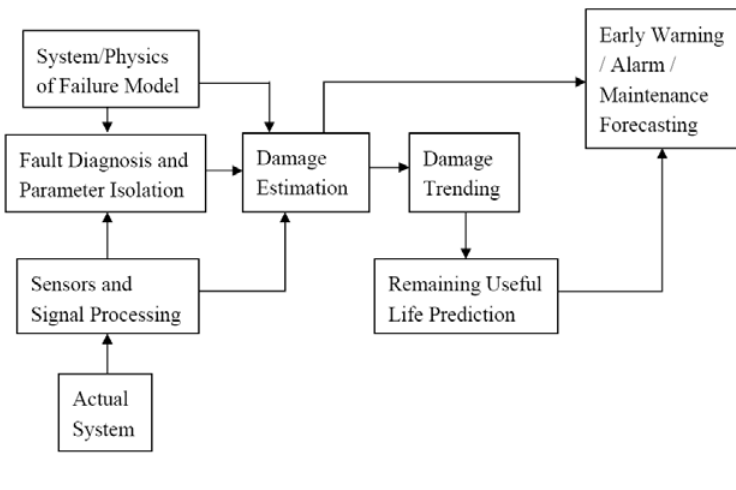
Figure 2. Block diagram of a model driven approach.